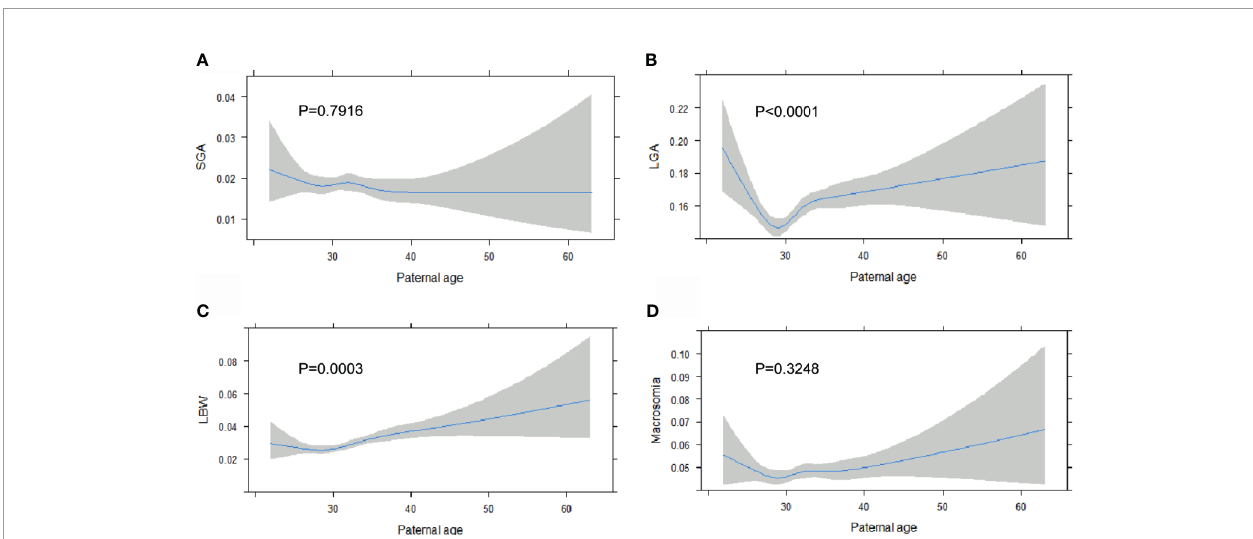
FIGURE 2 | Paternal age is associated with higher risk of adverse birth weight outcomes. Linear regression model is generated for paternal age at birth with the incidence of SGA (A) , LGA (B) , LBW (C) and Macrosomia (D) , expressed as predicted prevalence with 95% CIs. Analyses were adjusted for maternal age, BMI, ethnicity, education level and marital